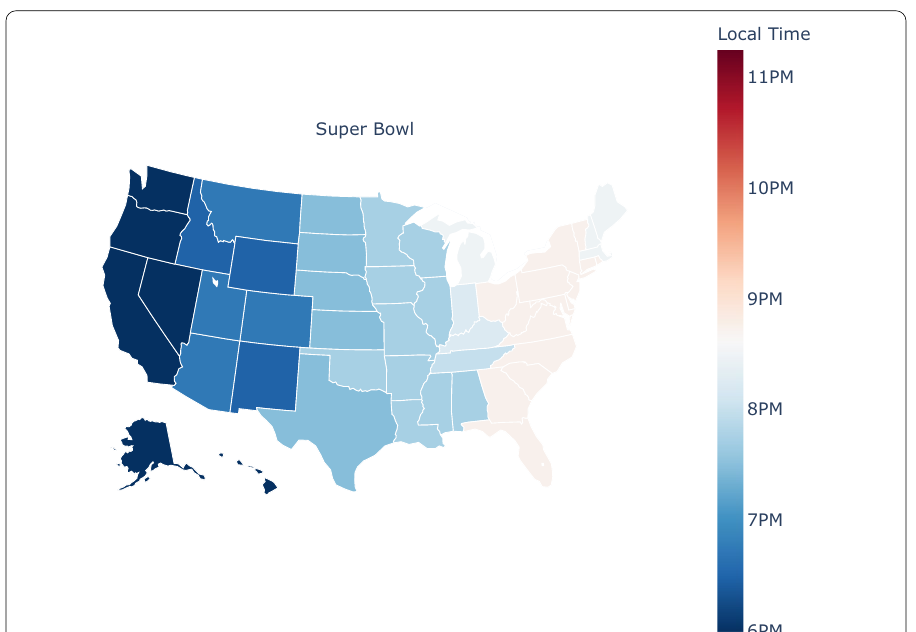
Fig. 6 Peak activity time (local) for Super Bowl Sunday, 5 weeks prior to Spring Forward, averaged over the years 2011 to 2014. Activity exhibits a clear resemblance to the U.S. timezone map, with a peak near 9 p.m. Eastern Time just following the halftime performance. The data suggests a national collective synchronization in attention. Green Bay Packers d. Pittsburgh Steelers (2011), New York Giants d. New England Patriots (2012), Baltimore Ravens d. San Francisco 49ers (2013), and Seattle Seahawks d. Denver Broncos (2014). Performers included The Black Eyed Peas, Usher, and Slash (2011), Madonna, LMFAO, Cirque du Soleil, Nicki Minaj, M.I.A., and Cee Lo Green (2012), Beyoncé, Destiny’s Child (2013), and Bruno Mars, Red Hot Chili Peppers (2014). We note that the colormap here the same as the scale used for 3, with blue colors included to reflect the relatively early times of the peaks relative to the other